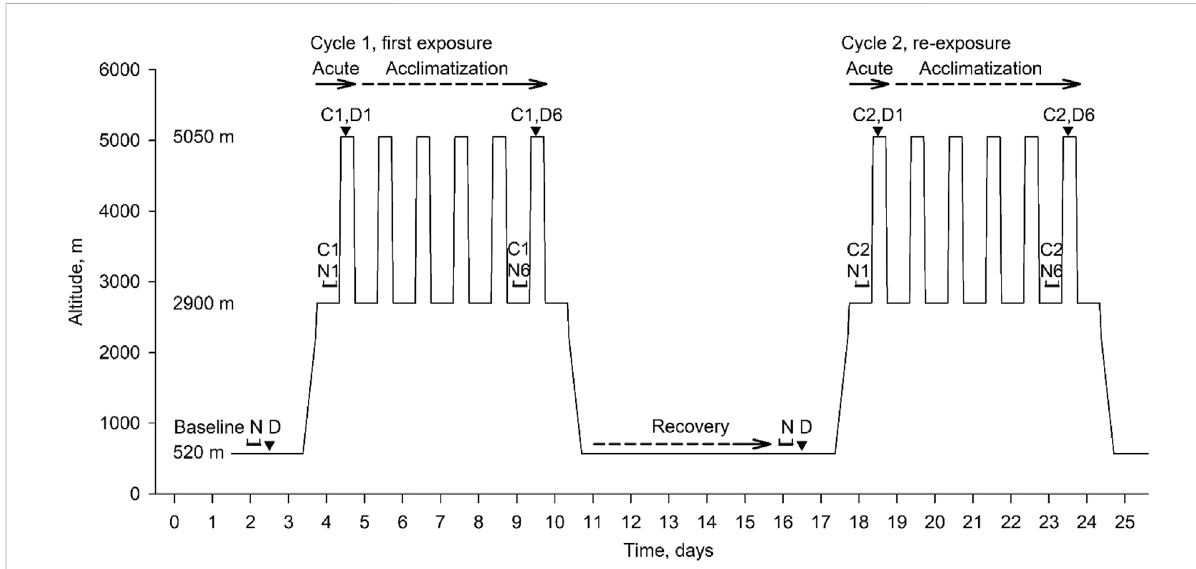
FIGURE 1 Overview of study design and data collection. The consecutive phases were: baseline period at 520 m, fi rst high altitude sojourn (Cycle 1, days 4 – 10, with nights spent at 2,900 m, days at 5,050 m); recovery period at 520 m, days 11 – 17; second altitude sojourn (Cycle 2, days 18 – 24). Assessments included overnight sleep studies (N) and daytime assessments (D). Effects of acute high altitude exposure were evaluated in Cycle 1 during night 1 and day 1 (C1, N1, C1, D1) in comparison to baseline night and day (N D); effects of acclimatization in Cycle 1 were evaluated in night6andday6(C1,N6,C1,D6)incomparisontothe fi rstnightandday.Correspondingevaluationstookplaceduringthehighaltitudere-exposure in Cycle 2. The acute effects of high altitude re-exposure were evaluated in Cycle 2 in comparison to overnight and daytime assessments at the end of the low altitude recovery